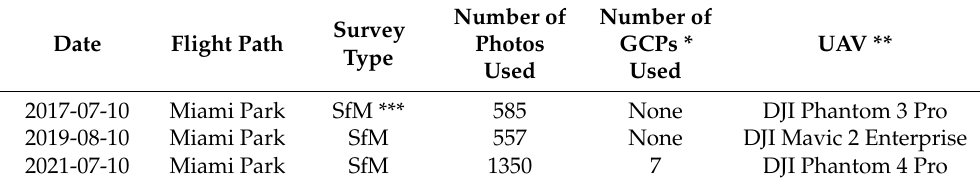
Table 1. Summary of UAV data